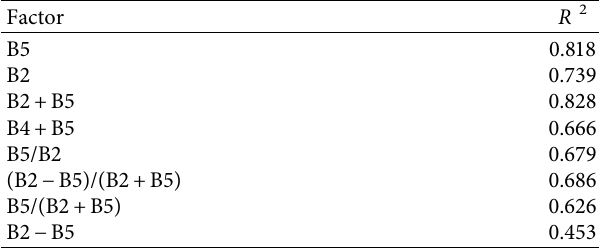
Table 2: Correlation index between COD and band.